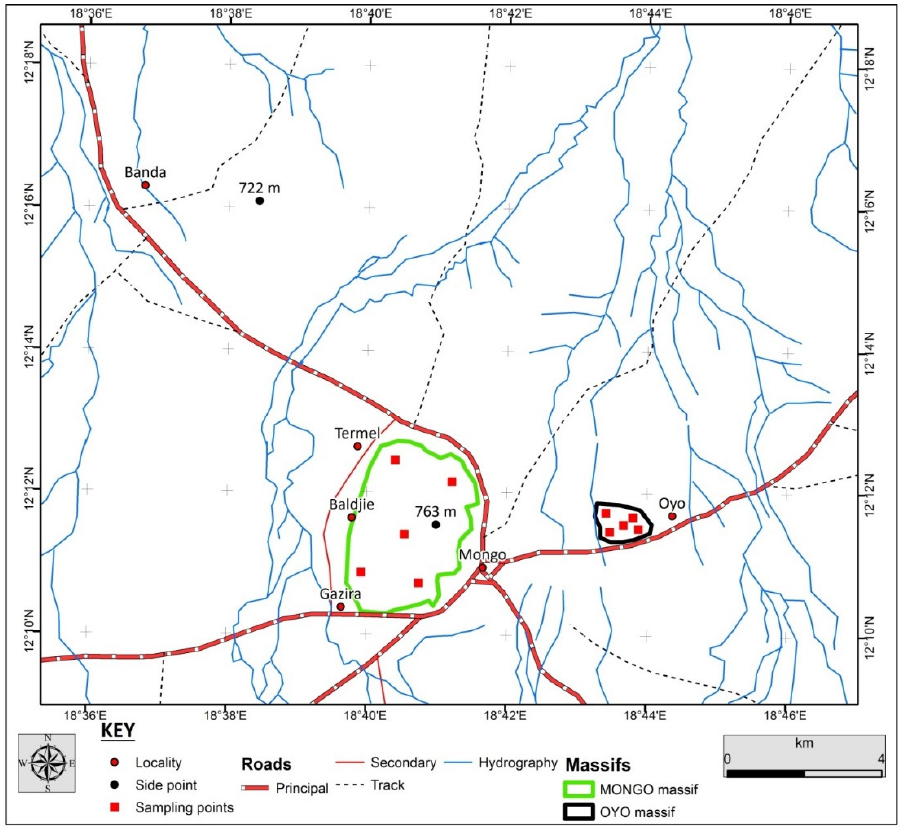
Figure 3. Sampling